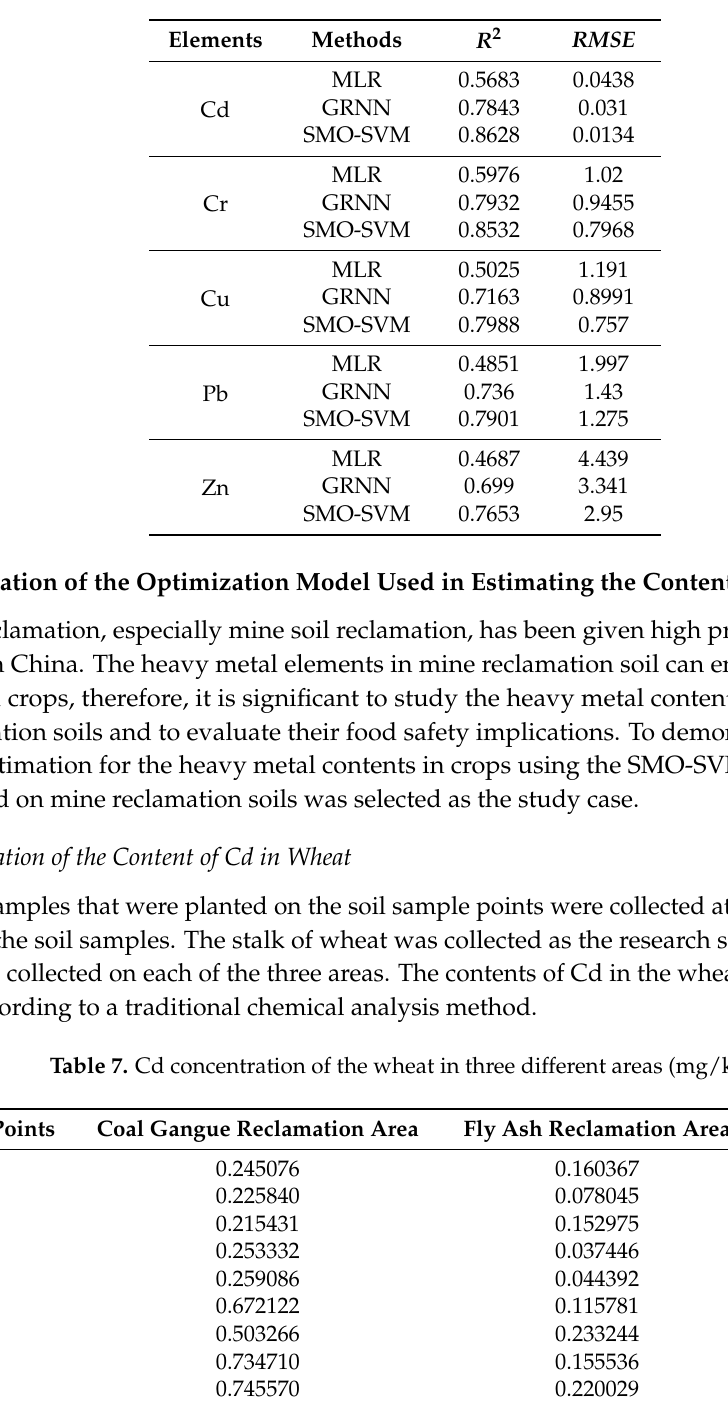
Table 6. Estimation results of the heavy metals in the reclamation soils of the mining area based on the three different models.